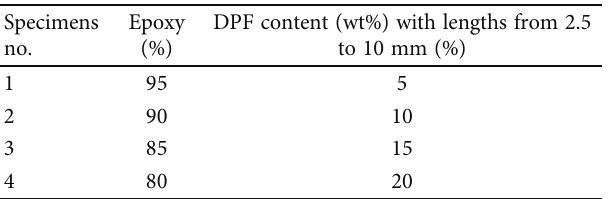
Figure 3: Silicone molds cavities used to fabricate specimens (i.e., creep, impact, and tensile). Table 3: The raw materials, which are used to prepare the